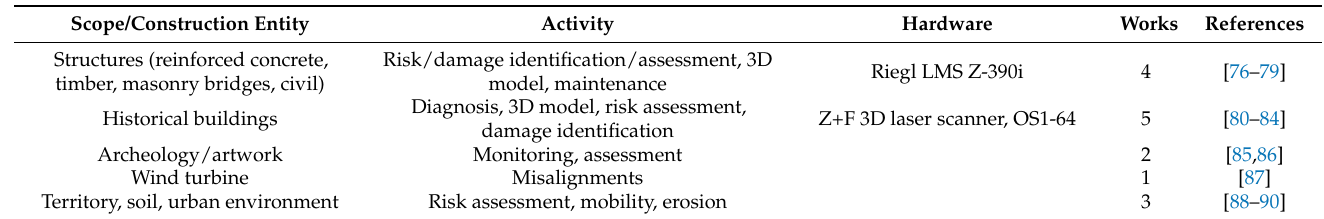
Table 3. Overview of the scope, topics, hardware used, and quantification of research works on “LiDAR” and